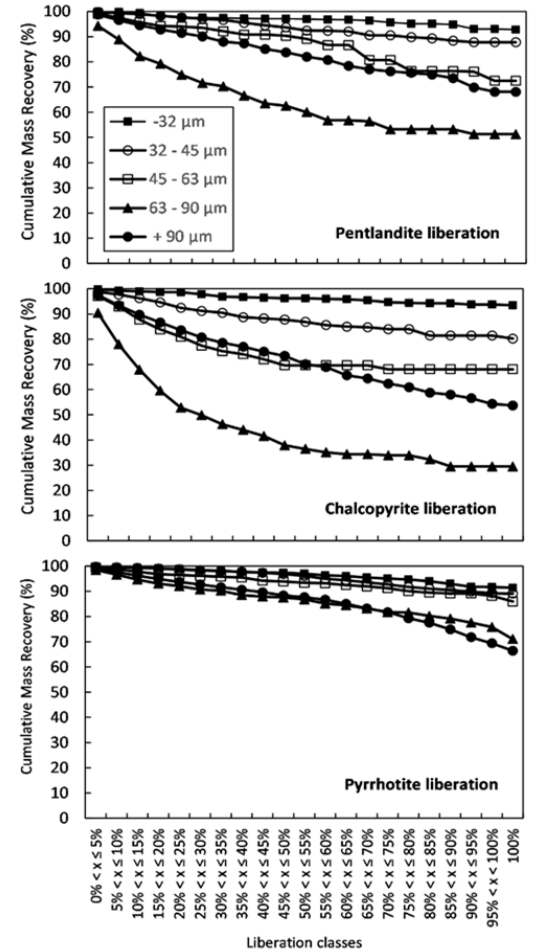
Figure 4. Liberation class of chalcopyrite (Cpy), pentlandite (Pn), and pyrrhotite (Po) in the